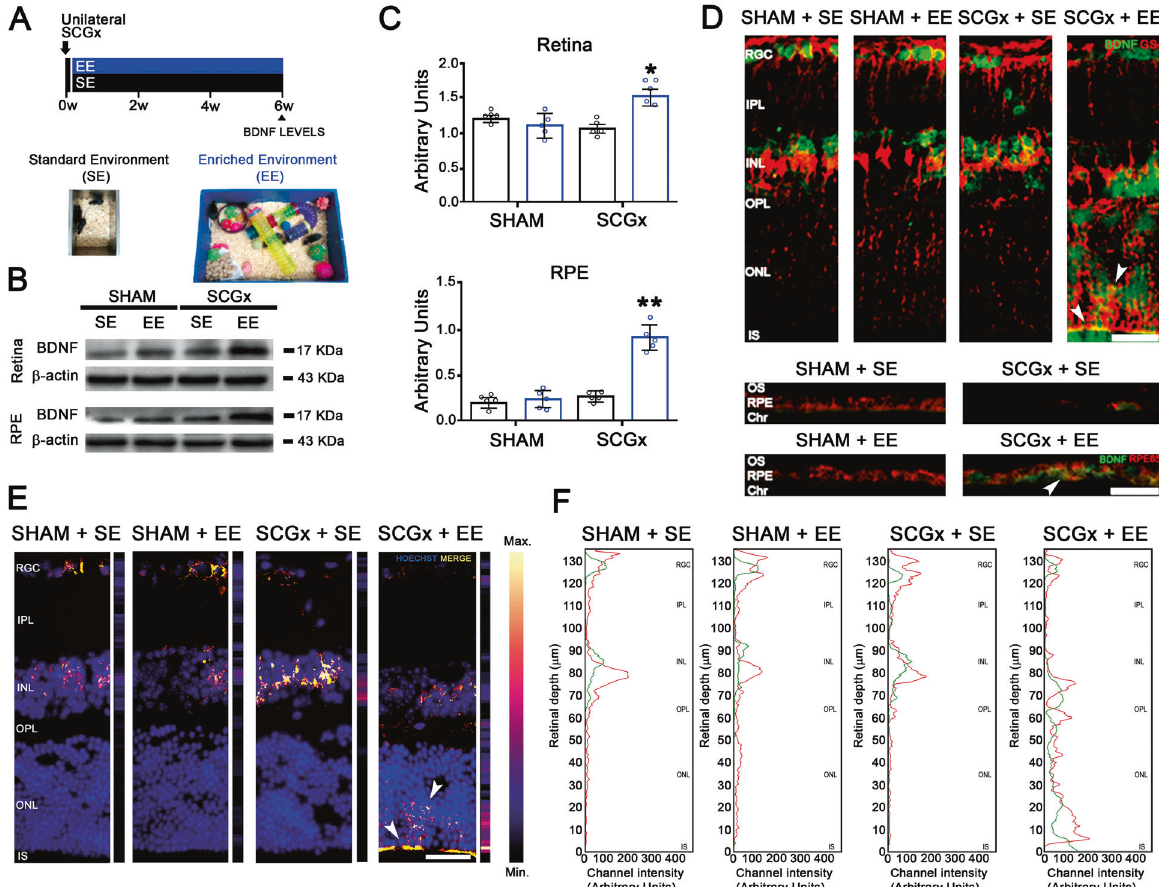
Fig. 4 Effect of EE on the temporal retina/RPE BDNF-immunoreactivity and protein levels, and temporal retina BDNF/GS co-localization at 6 weeks post-SGCx. A Experimental protocols. B , C BDNF levels were signi fi cantly increased in SCGx-treated eyes from animals housed in EE both at the retina and RPE. Data are mean ± SEM ( n : 5 homogenates per group), ** P < 0.01, * P < 0.05 vs. sham-treated eyes from SE animals, by Tukey ’ s test. D EE, which had no effect on BDNF-immunoreactivity in sham-treated eyes, increased this parameter at the retina and RPE from SCGx eyes, particularly at the OPL, ONL and IS layers. Shown are representative photomicrographs at 800 μ m temporally from the ONH from 5 eyes/group. RGC retinal ganglion cell layer, IPL inner plexiform layer, INL inner nuclear layer, OPL outer plexiform layer, ONL outer nuclear layer, IS PR inner segments, OS PR outer segments, RPE retinal pigment epithelium, Chr choroid. Scale bars = 30 μ m. E Exclusive merge (yellow) from GS- and BDNF-immunoreactivity pictures were analysed using Python software. BDNF immunoreactivity was exclusively increased at the outer retina in SCGx-treated animals housed in EE. F Analysis of the red (GS) and green (BDNF) pixels from GS- and BDNF- immunoreactivity pictures also analysed using Python software. At the retinas from sham-treated eyes and SCGx-treated eyes from SE animals merge ( E ) and coincident peaks in red and green pixels ( F ) were evident mainly at the GCL and the INL, whereas in SCGx-treated eyes from EE animals, GS- and BDNF-immunoreactivity merge ( E ), and red and green pixel peaks ( F ) particularly increased at the outer retina and Müller cell end feet. Shown are representative photomicrographs from 5 eyes/group, at 800 μ m temporally from the ONH. RGC retinal ganglion cell layer, IPL inner plexiform layer, INL inner nuclear layer, OPL outer plexiform layer, ONL outer nuclear layer, IS PR inner segments, OS PR